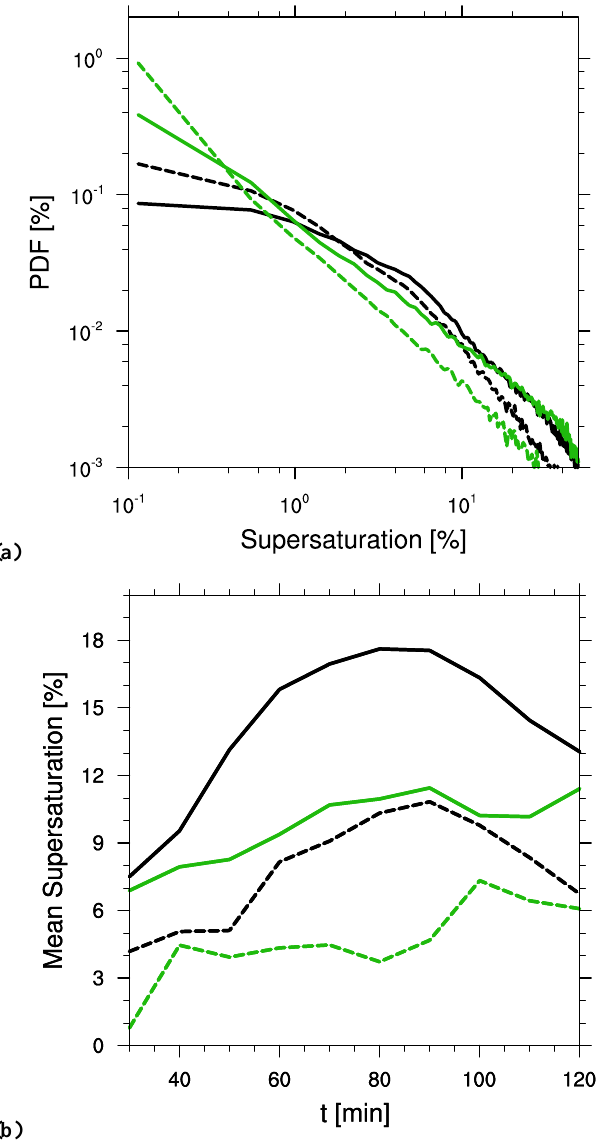
Fig. 12. (a) Probability distribution function (PDF) of the super- saturation and (b) conditionally-averaged supersaturation as a func- tion of time. Shown are results for the bulk-explicit (black) and bin (green) model configurations for the “Clean” (solid) and “Polluted” (dash) aerosol scenarios. The PDFs are generated by analyzing all points for which 2.1km ≤ z ≤ 9.1km and 30min ≤ t ≤ 120min. In (b) , only points in which the supersaturation is positive are con- sidered when computing the